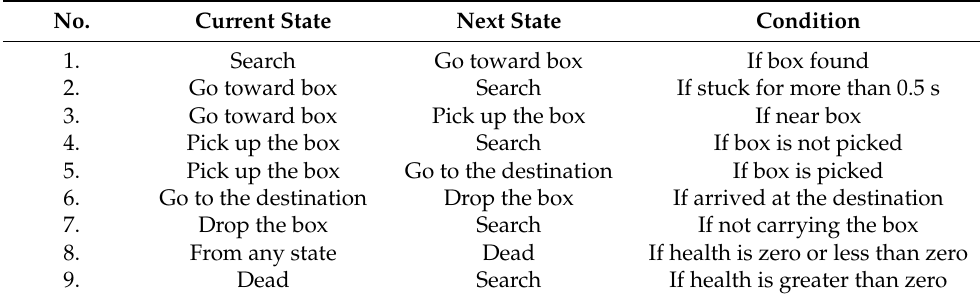
Table 1. Transitions between bot